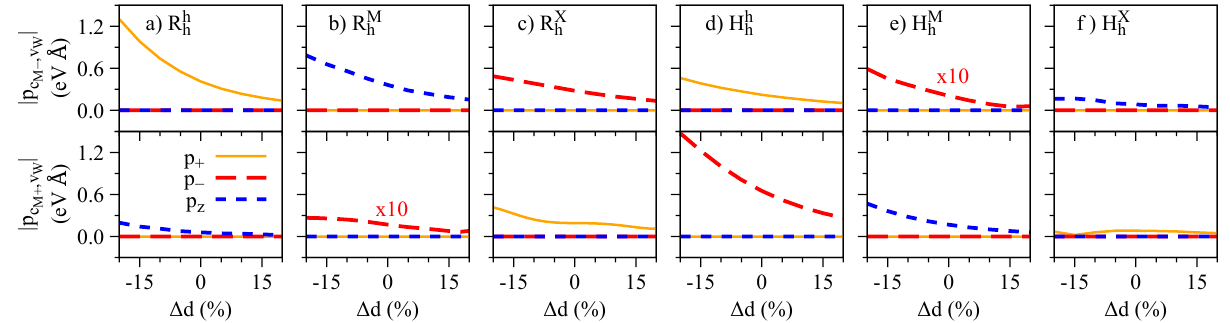
Figure 15. Same as Figure 12 but as a function o the interlayer